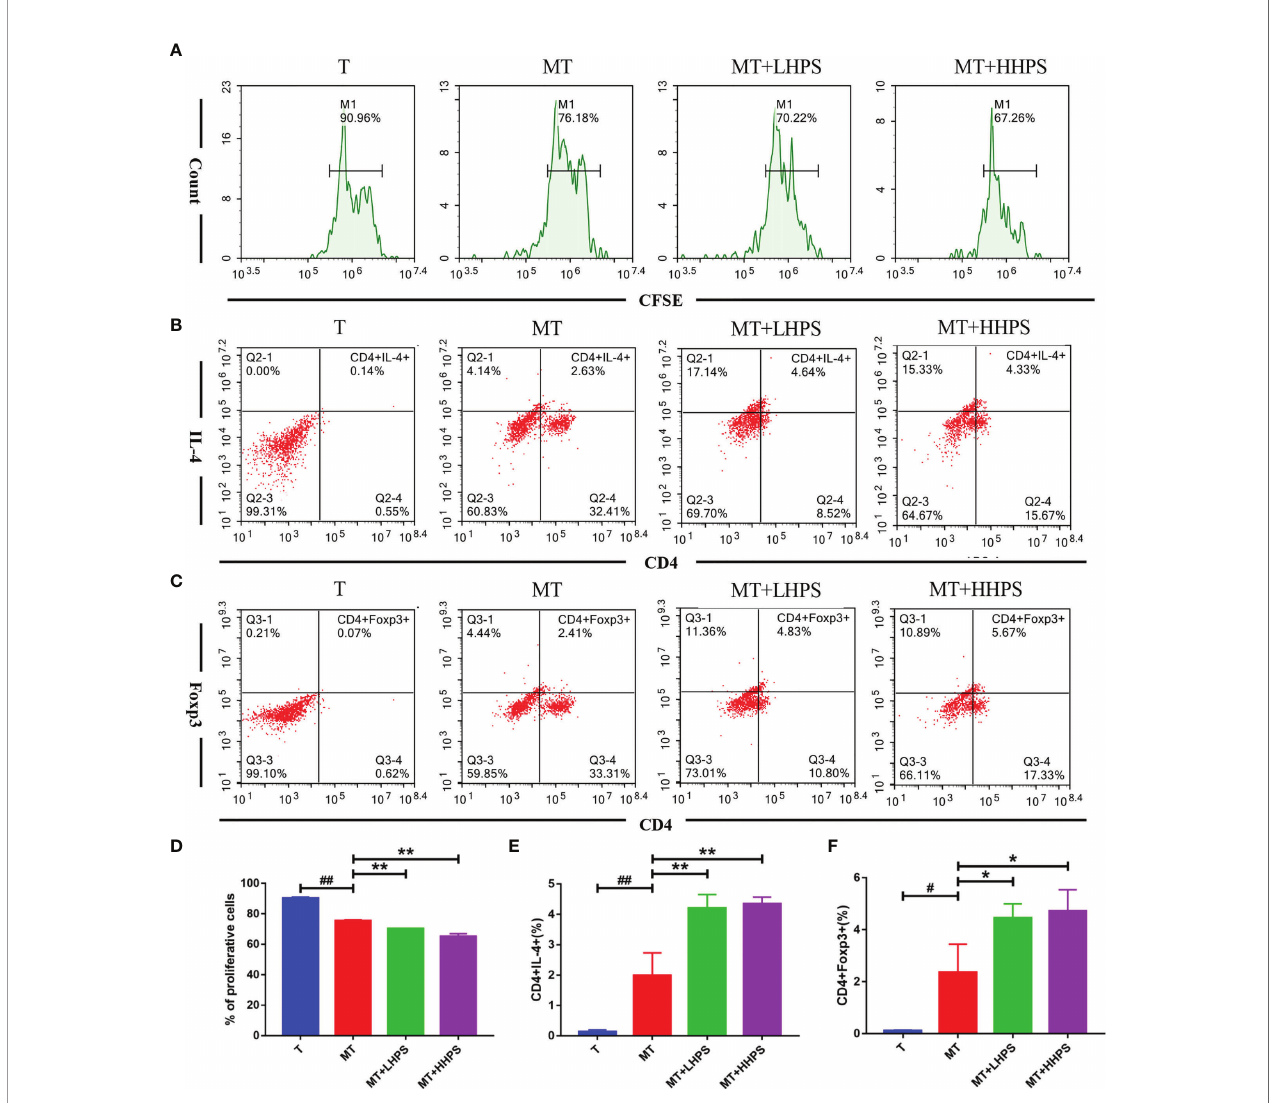
FIGURE 10 | Hyperoside suppresses T cell proliferation while increasing Th2 or Foxp3+ Treg generation in the co-culture with M2 macrophages. T cells cocultured with M2 macrophages at a ratio of 1:10 (T cell/M2 macrophages) were treated with high-dose HPS (HHPS) (50uM) or low-dose HPS (LHPS) (12.5uM) for 72hrs, and then analyzed via fl ow cytometry. (A, D) For proliferation assays, T cells were fi rst labeled with CFSE before the co-culture, and the CFSE dilution of CFSE-labeled CD4 + T cells was detected by fl ow cytometry. Flow cytometric analysis showed T-cell proliferation was inhibited by addition of M2 macrophages to the coculture system, and the inhibition was further enhanced by HPS. (B, E) The percentage of IL4-expressing CD4 + T cells was increased by HPS treatment compared with a control group (MT). (C, F) The percentage of CD4 + Foxp3 + T cell subsets was also increased by HPS treatment compared with a control group (MT). Differences between experimental groups were evaluated using ANOVA ( # P < 0.05 and ## P < 0.01 vs T group; * P < 0.05 and ** P < 0.01 vs MT group). T, T cells alone; MT, T cells cocultured with M2 macrophages; MT+LHPS, T cells cocultured with M2 macrophages treated with low-dose HPS (12.5 m M); MT+HHPS, T cells cocultured with M2 macrophages treated with high-dose HPS (50 m